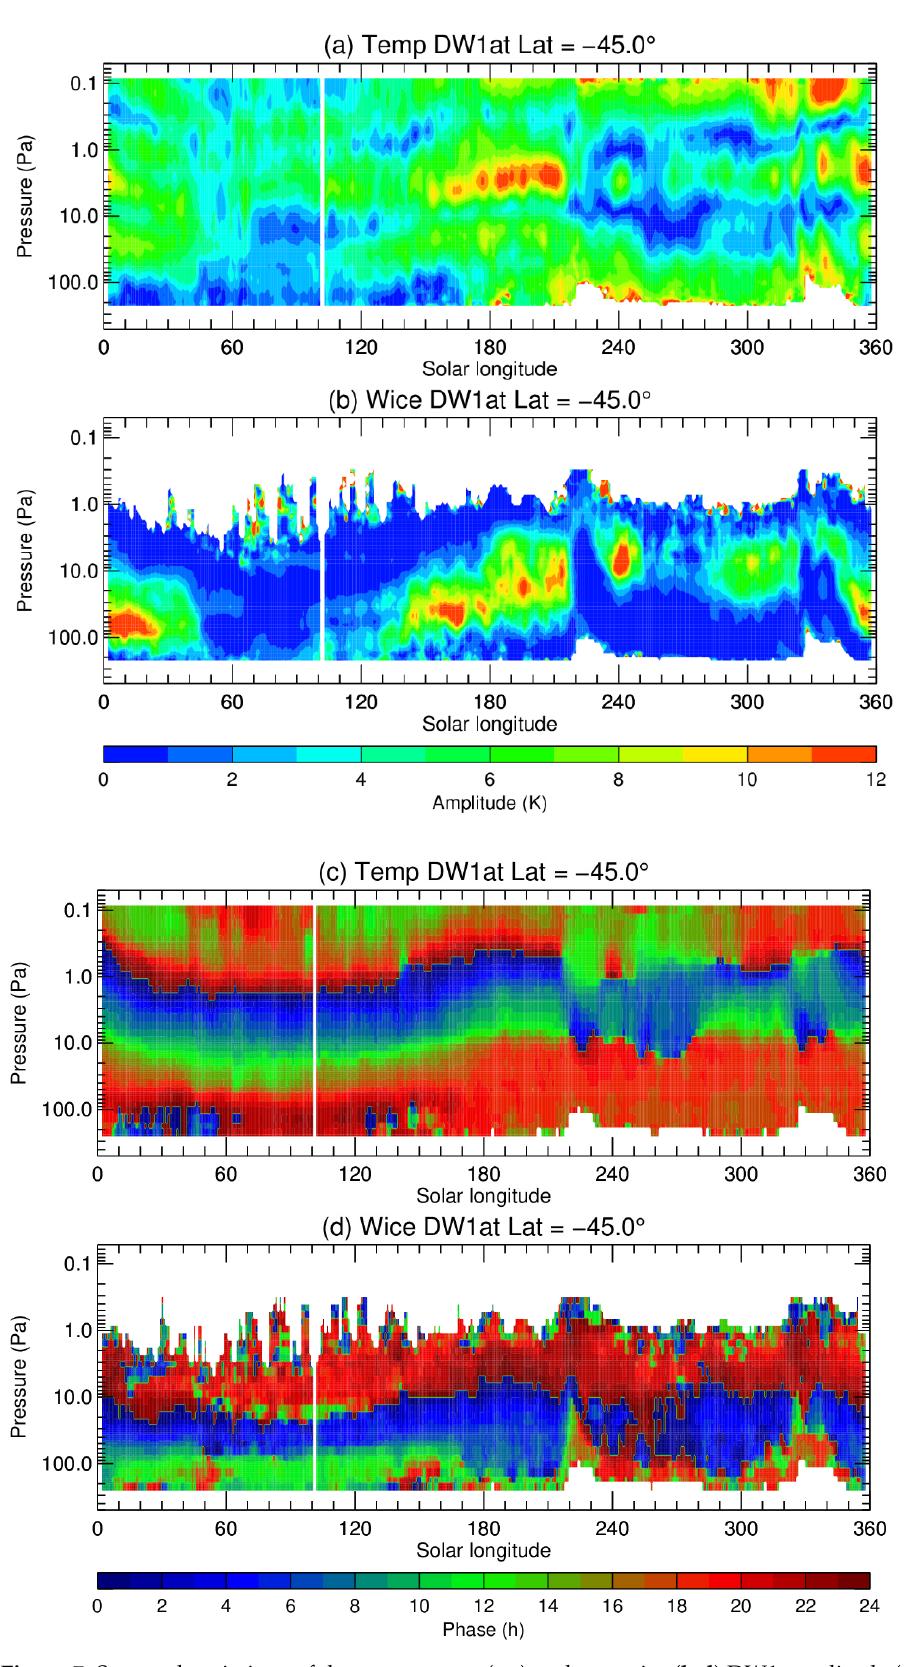
Figure 7. Seasonal variations of the temperature ( a , c ) and water ice ( b , d ) DW1 amplitude ( a , b ) and phase ( c , d ) at 45°S. Note that the water opacity value has been multiplied by 10 4 .